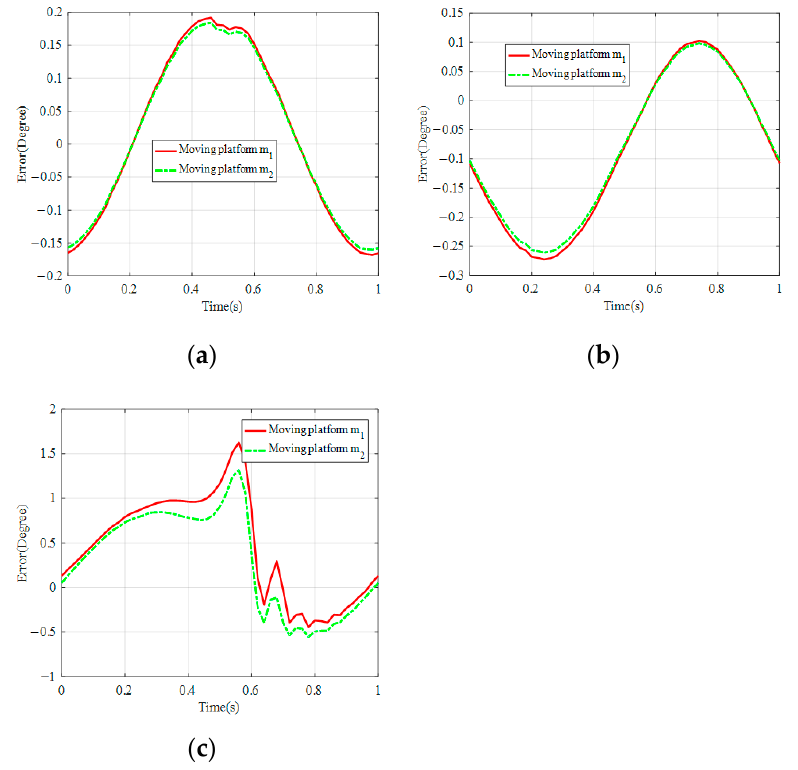
Figure 7. Errors of the posture angles of the moving platform. ( a ) AA error; ( b ) IER error; ( c ) EE Error.